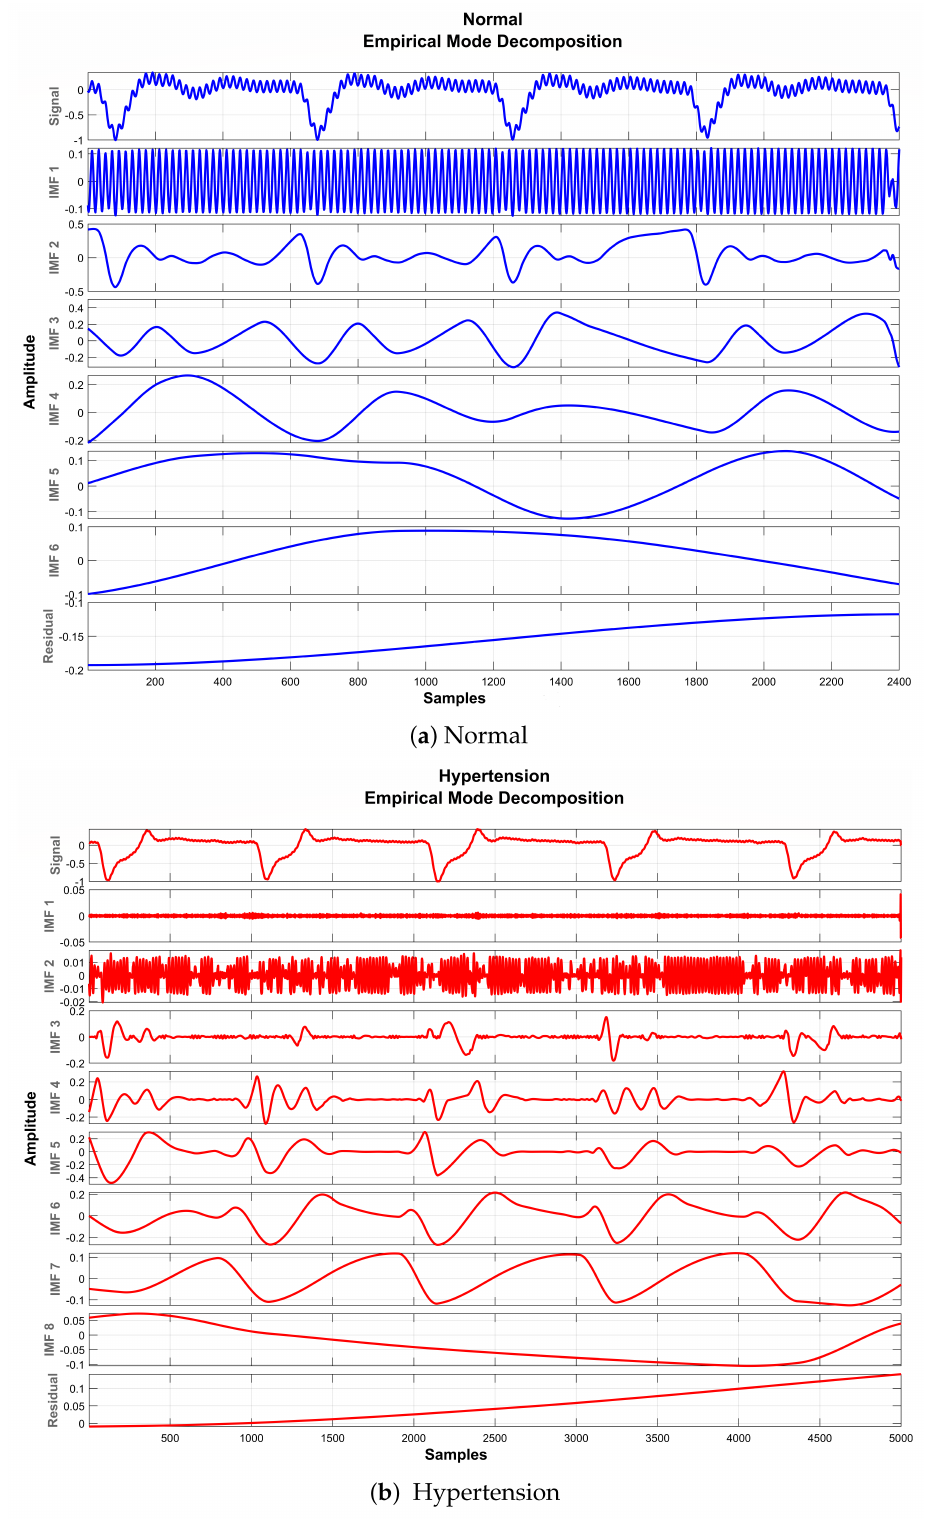
Figure 8. EMD decomposition of raw PuPG